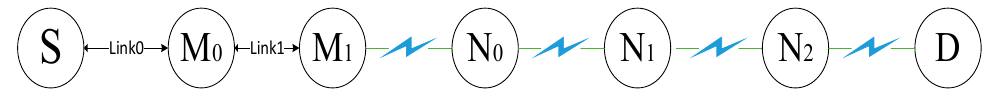
Figure 1. Simulation scene